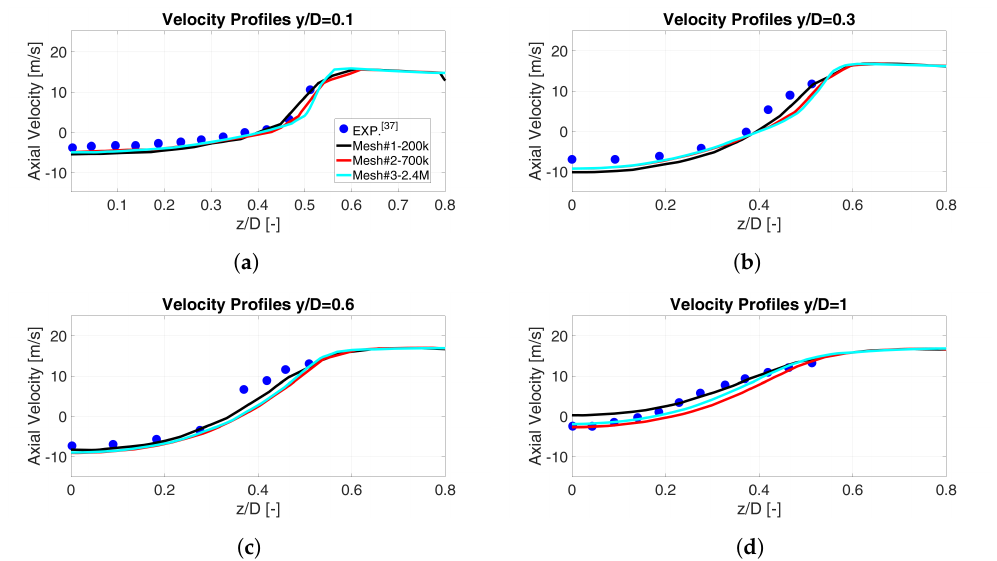
Figure 5. Mesh refinement: comparison between the experimental and the numerical results in terms of the axial velocity profiles at different axial positions (( a ) y / D = 0.1, ( b ) y / D = 0.3, ( c ) y / D = 0.6, ( d ) y / D = 1) − reacting